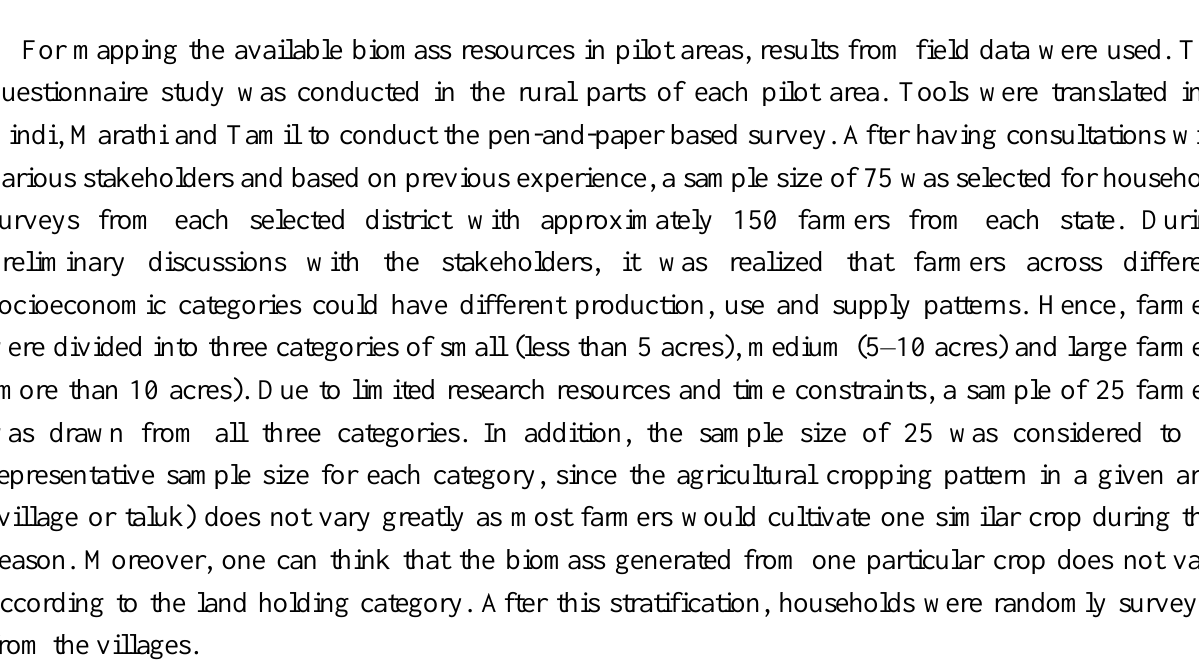
Figure 2. State-level study regions and selected pilot cities including the mapped pilot